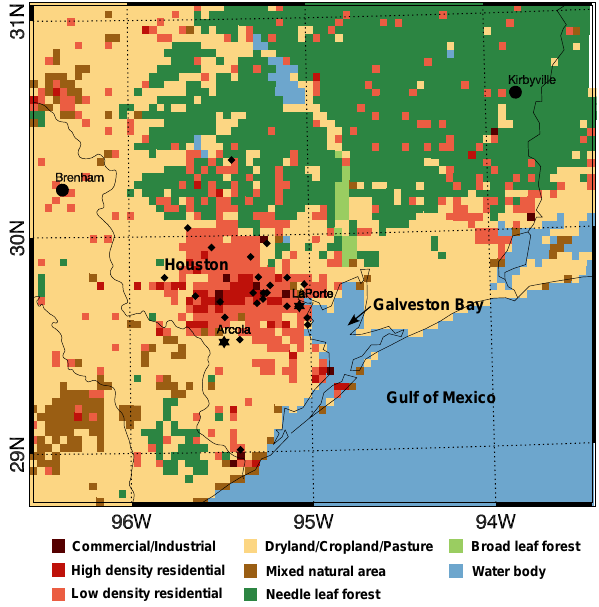
Fig. 2. Spatial distribution of dominant land-use types around the Houston-Galveston Bay area in the nested domain. The geograph- ical locations of surface (meteorological) sites (solid diamond), radar wind profilers (solid star with a site name), and surface en- ergy balance flux sites (solid circle with a site name) are